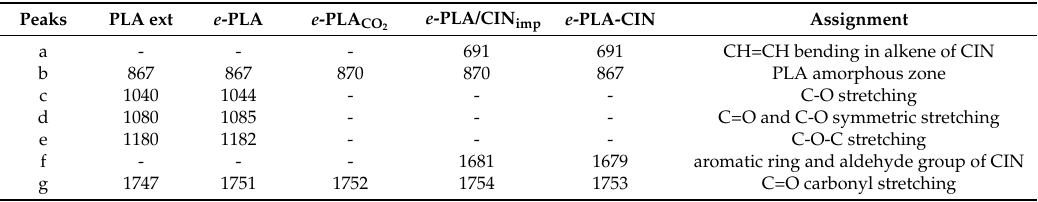
Table 2. Characteristic wavenumbers expressed in (cm -1 ) assigned to FTIR absorption bands of PLA mats.